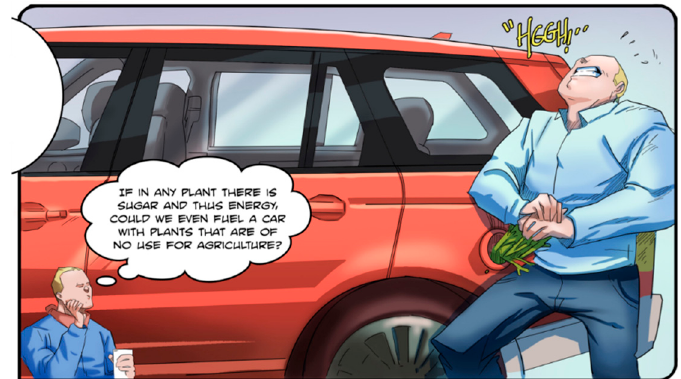
Figure 5. Fuel-guzzling SUV being fueled with halophytes.